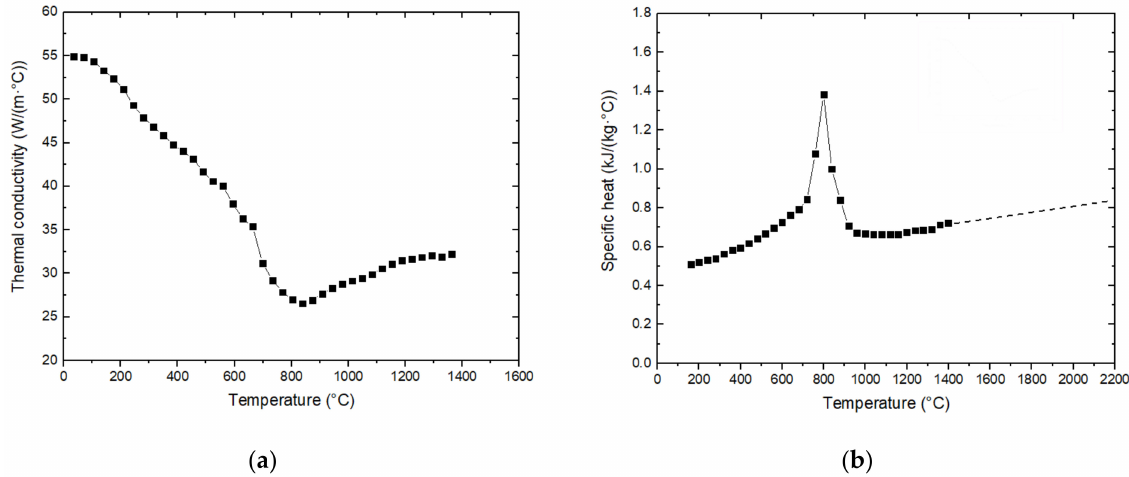
Figure 7. Material properties: ( a ) thermal conductivity; ( b ) specific